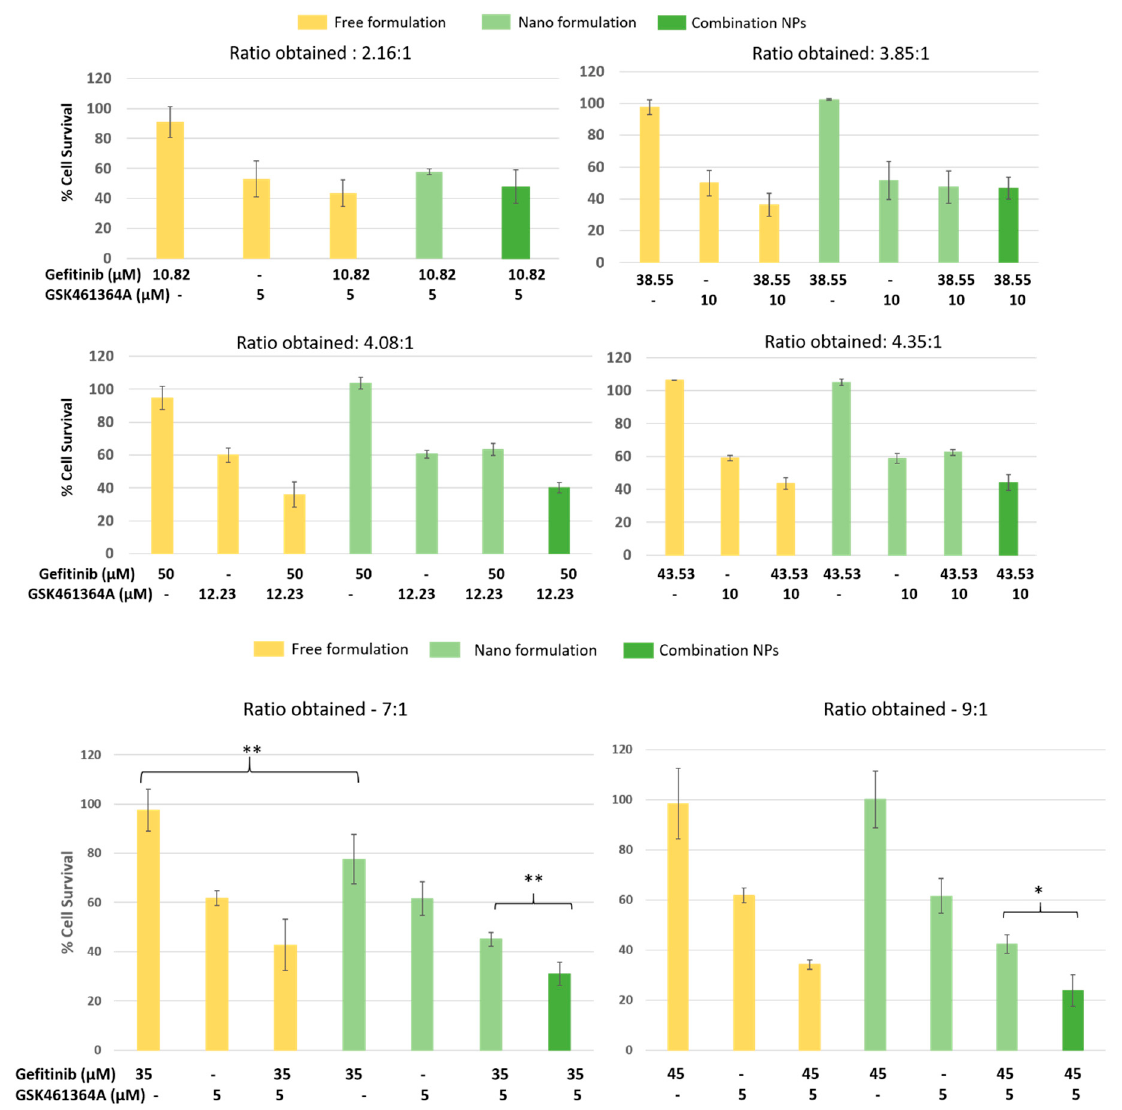
Figure 8. In vitro cytotoxicity assay showing difference in cell viabilities when treated with combination NPs arranged in the increasing molar ratios of gefitinib: GSK461364A. * p < 0.05, ** p < 0.005.